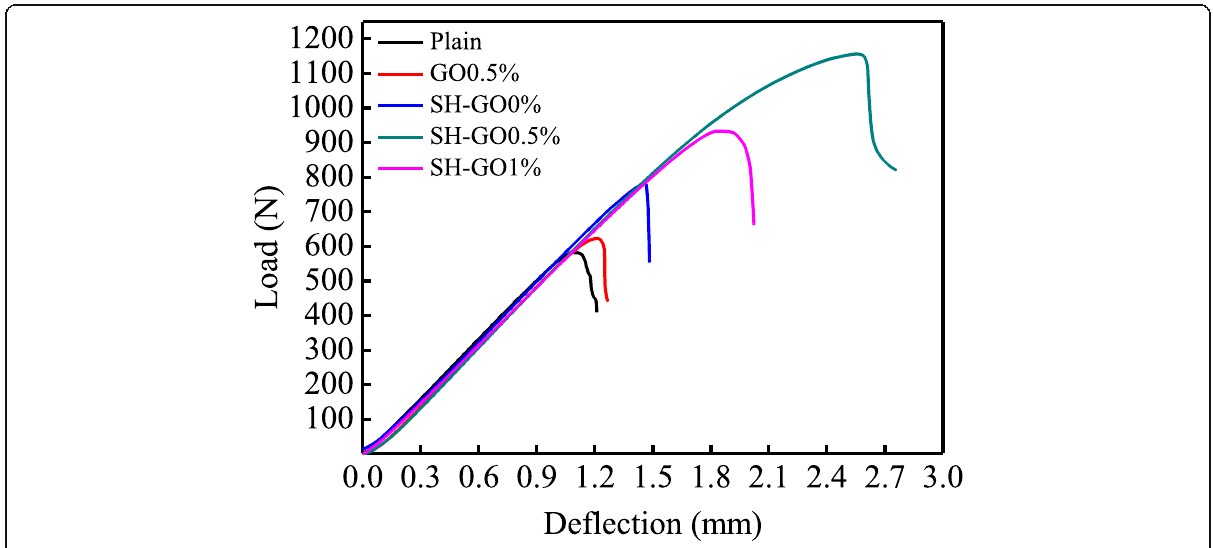
Fig. 12 Representative load-deflection curves for different specimens during ENF tests